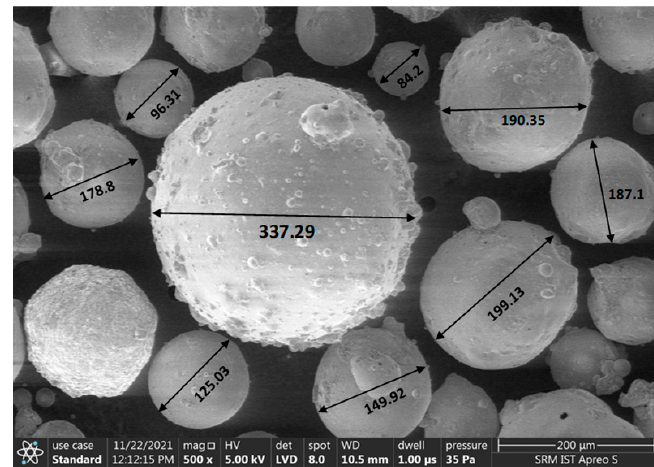
Figure 2. SEM Image of Fly Ash Cenosphere.